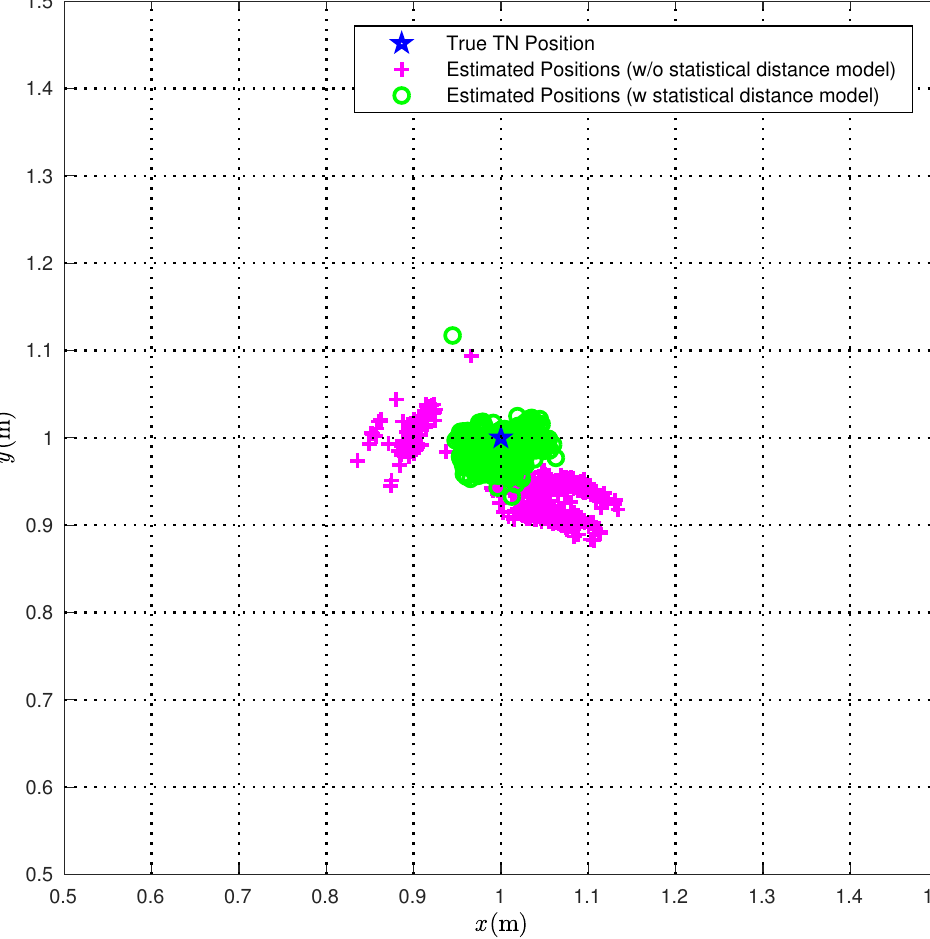
Figure 6. The 1000 position estimates obtained with the CI localization algorithm are shown (magenta plus), together with the 1000 position estimates obtained when taking into account the statistical model for range estimates (green circles) and the TN (blue